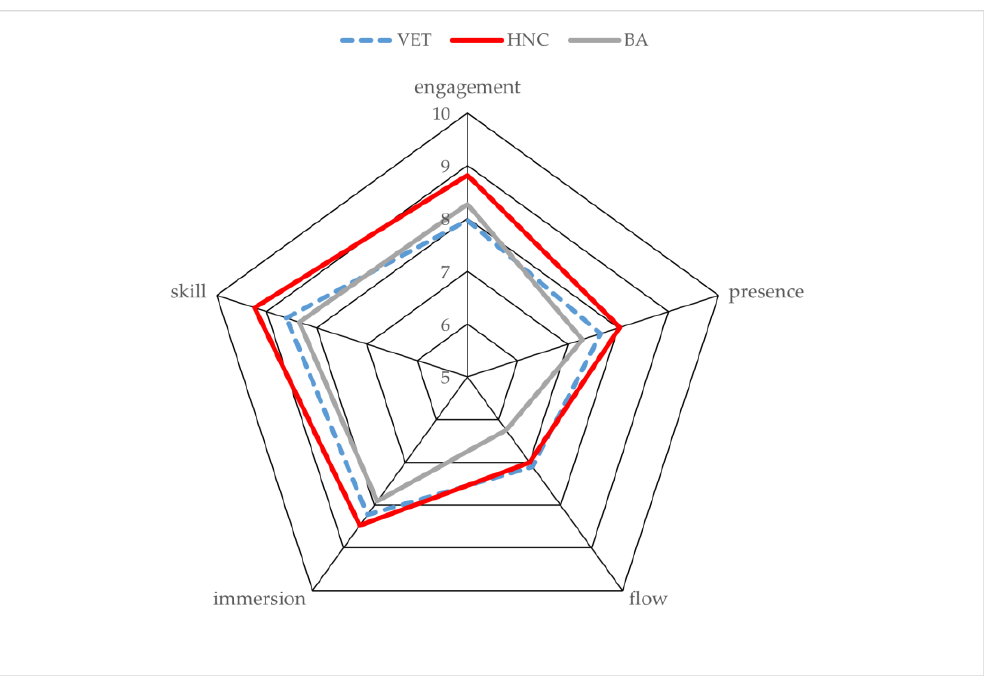
Figure 8. Radar plot of the usability and satisfaction survey of the three groups (scale 5 to 10).